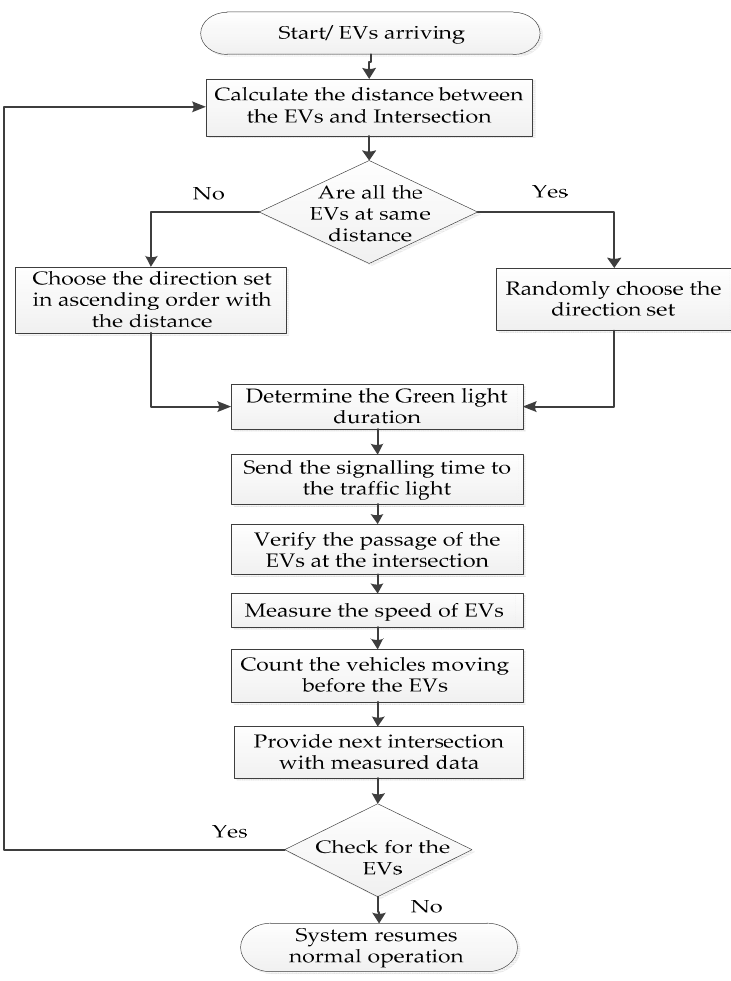
Figure 4. Distance-based emergency vehicle dispatching algorithm.